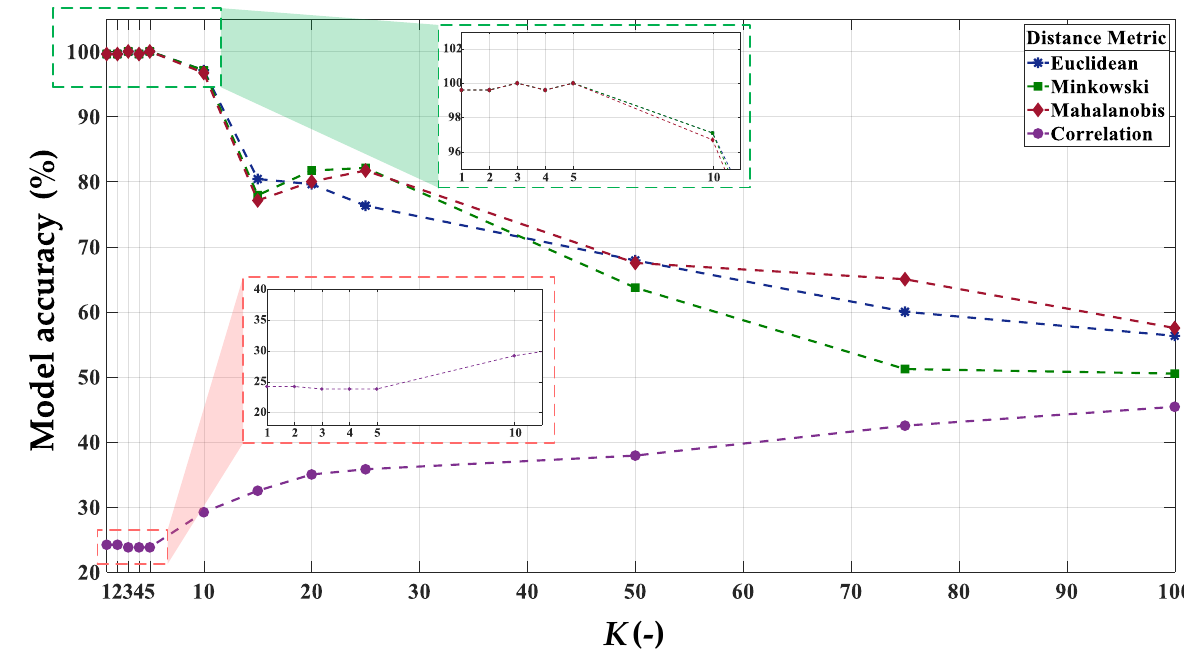
Figure 9. Distribution of the proposed fault features for different N sh .